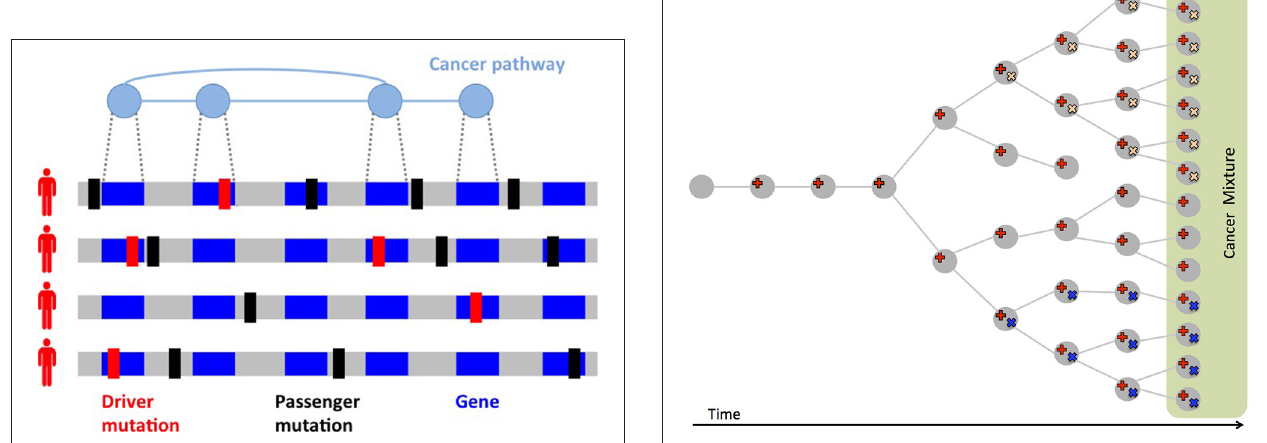
FIGURE 2 | Intra-tumor heterogeneity and its causes. Cancer evolves from a normal cell that accumulates mutations (in red, yellow, and blue), leading to different clones , populations of cells of different genotypes, coexisting in the same tumor. Bulk sequencing measures mutations from a sample of the resulting cell mixture, that also comprises normal cells. The fraction of reads supporting a mutation (VAF) is proportional to the number of cells with the mutation in the